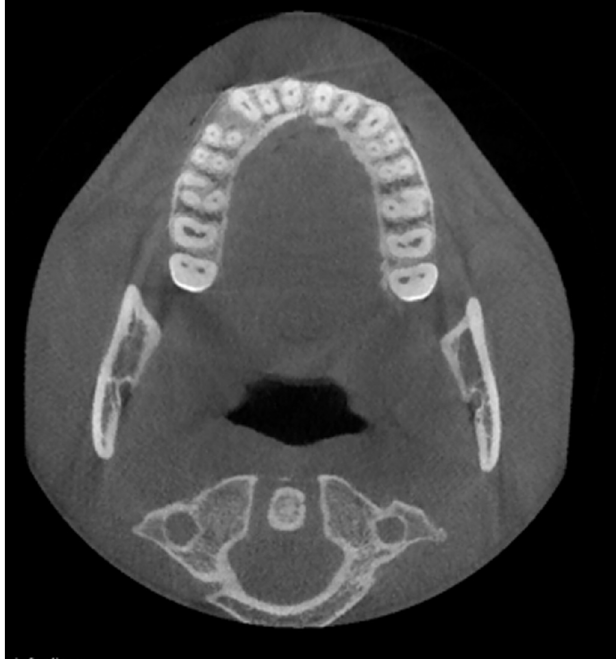
Fig. 6. CBCT 8 months after the surgical intervention. Axial section shows no recurrence of the initial